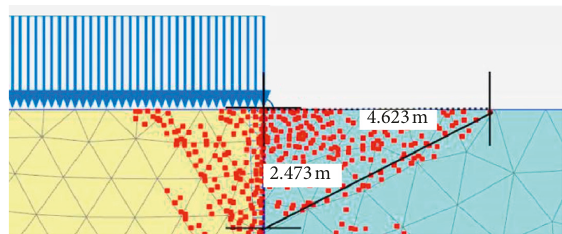
Figure 15: Distribution of failure points inside the foundation pit at φ � 35 ° .